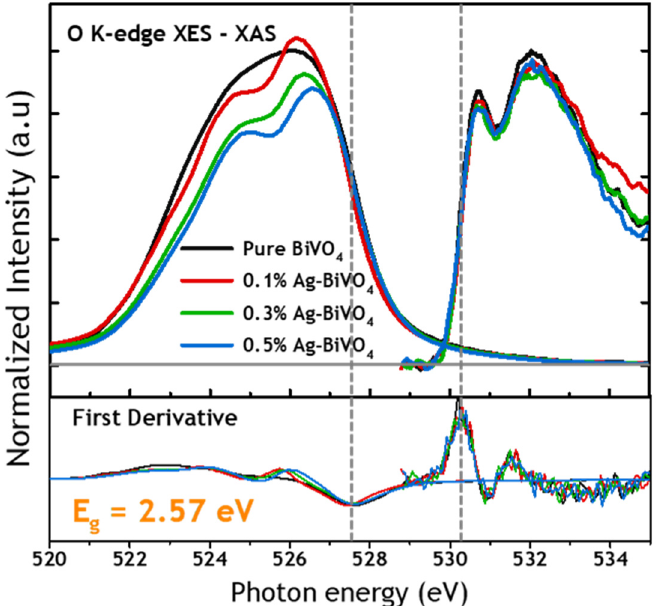
Figure 4. O K-edge XES-XAS spectra of pure BiVO 4 and Ag–BiVO 4 . The first derivatives of all spectra are plotted underneath. Vertical lines indicate energy separation between two edges.